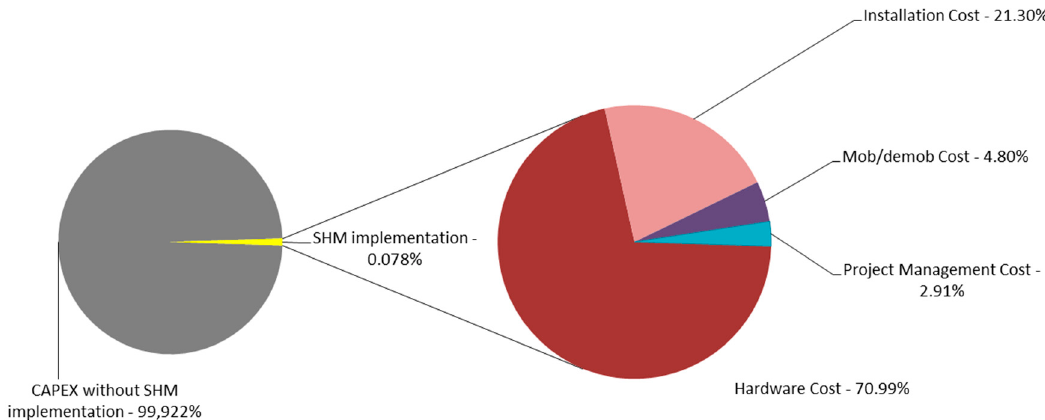
Figure 3. CAPEX increase due to SHM implementation in Scenario 3, average case of hardware costs.